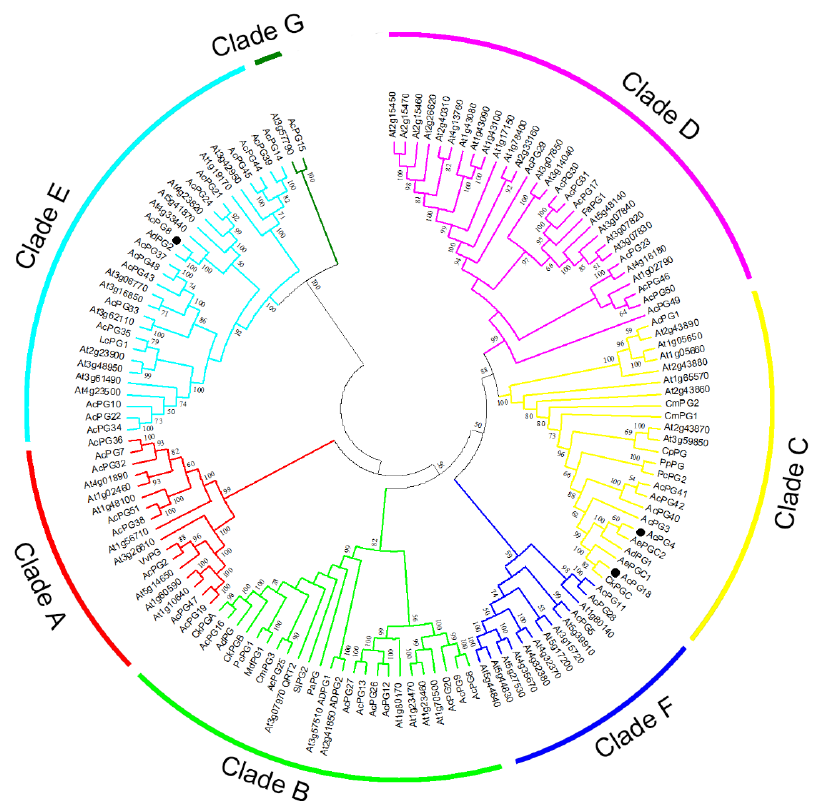
Figure 2. Phylogenetic relationship analysis of PGs from kiwifruit and other plants. Multiple alignments of full-length protein sequences of PGs from kiwifruit and other plant species were performed by Clustal W, and the phylogenetic tree was constructed using MEGA 6.0 by the Neighbor-Joining method. Numbers on branches indicate the bootstrap percentage values from 1000 replicates, and values lower than 50 are hidden in the phylogenetic tree. Three PG genes from kiwifruit ( AcPG4 , AcPG8 and AcPG18 ) were indicated by black circles. The protein sequences of AtPG gene family members from Arabidopsis thaliana were retrieved from TAIR database, and the protein sequences of